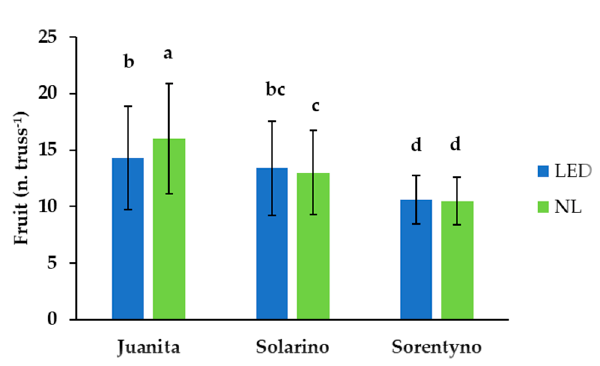
Figure 4. Average number of fruit per truss during growing cycle of three tomato cultivars grown with LED, used as supplemental light, and with natural light. Vertical bars indicate ± SE. The same lowercase letters indicate that the mean values are not significantly different ( p = 0.05).